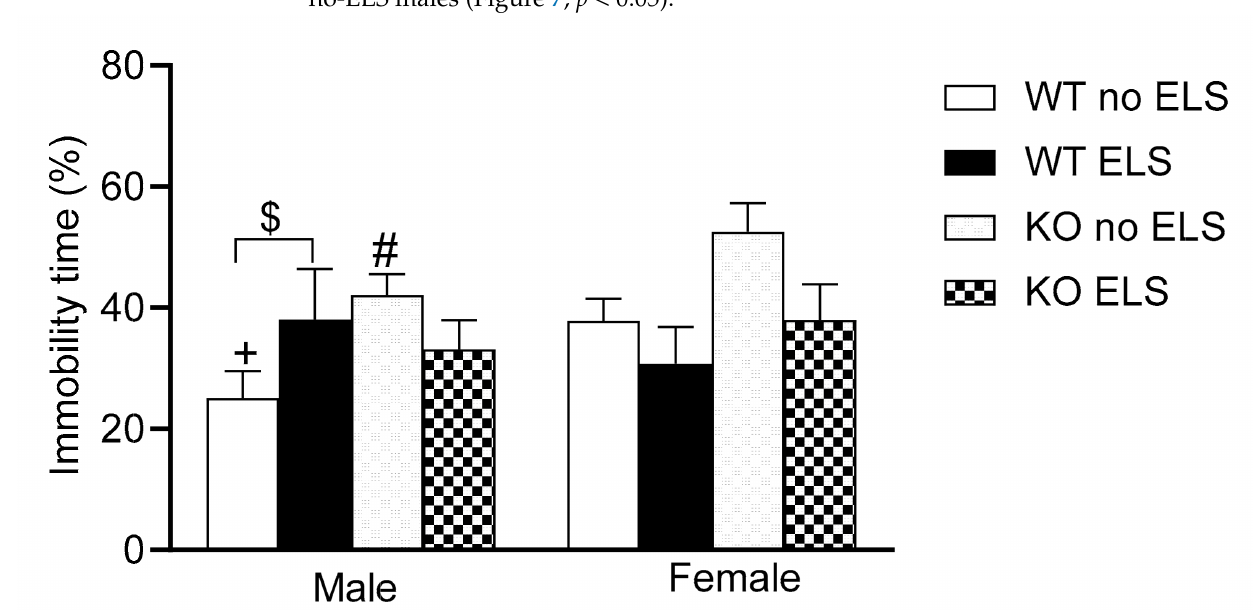
Figure 5. Effect of ELS on WT and GPR37KO mice on time spent immobile in forced swim task. N/group: WT no-ELS male = 8, WT ELS male = 7, KO no-ELS male = 9, KO ELS male = 9, WT no-ELS female = 8, WT ELS female = 7, KO no-ELS female = 8 and KO ELS female = 8. All data represent mean ± SEM. # p < 0.05 versus corresponding WT; + p < 0.05, with respect to sex; $ p > 0.05 < 0.1 calculated by three-way ANOVA followed by multiple comparisons using the two-stage linear step- up procedure of Benjamini, Krieger and Yekutieli. WT = Wild Type, KO = Knock Out, ELS = Early Life